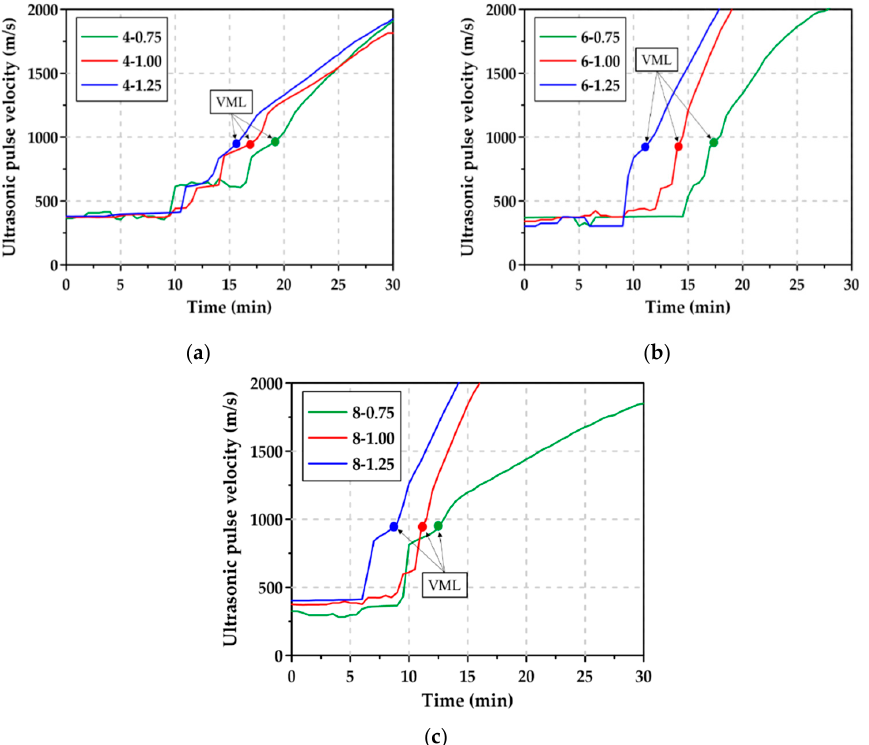
Figure 9. UPV curves for AAS pastes: ( a ) Na 2 O content = 4%, ( b ) Na 2 O content = 6%, ( c ) Na 2 O content = 8%.